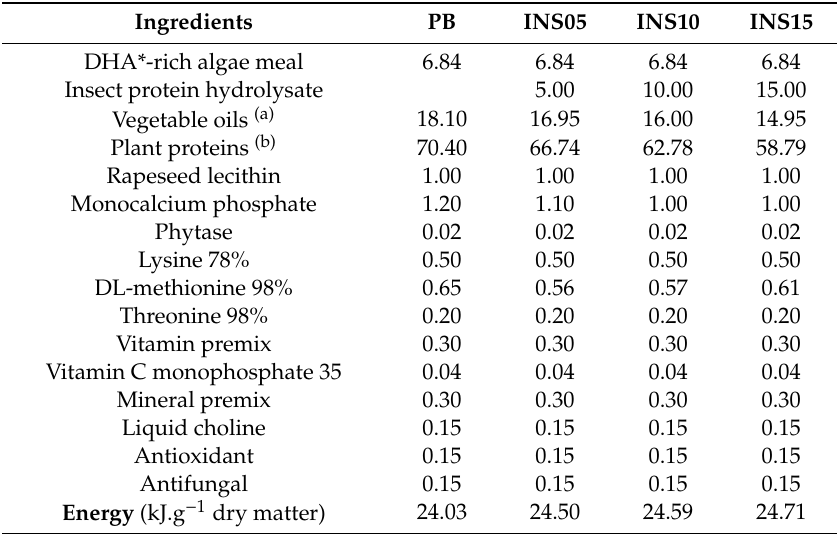
Table 2. Diet formulation (g.100 g − 1 ) of control diet (PB) and experimental diets (INS05, INS10, INS15). Ingredients and gross